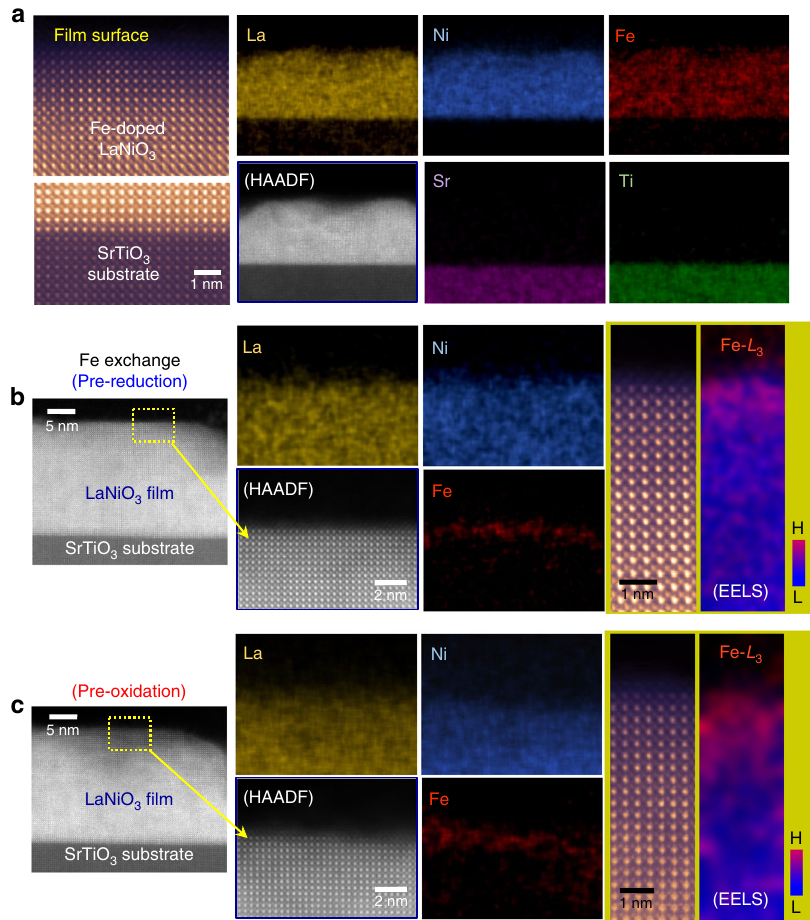
Fig. 1 Fe incorporations in LaNiO 3 epitaxial thin fi lms. All the thin fi lms were fabricated on (001) SrTiO 3 substrates. a The composition of the fi lm is La (Ni 0.9 Fe 0.1 )O 3 . This set of energy-dispersive X-ray spectroscopy (EDS) maps clearly shows the homogenous distribution of Fe over the entire fi lm, verifying a solid-solution. The high-angle annular dark- fi eld (HAADF) image in the left-hand column proves the high crystallinity and epitaxial growth of the fi lm. b , c These LaNiO 3 fi lms were subjected to surface Fe exchange by pre-reduction ( b ) and pre-oxidation ( c ) reactions. The presence of Fe in each surface region is con fi rmed by both EDS and electron energy-loss spectroscopy (EELS) mapping. In particular, the EELS maps and corresponding atomic-column images in the right-hand column show that a detectable amount of Fe is observed down to 3 – 5 unit cells below the